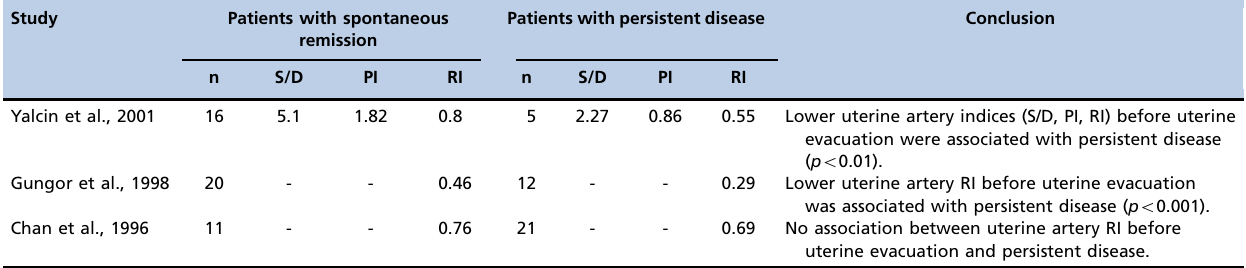
Table 1 - Studies that evaluated the correlation between UA Doppler indices and the development of post-molar trophoblastic tumors before uterine evacuation. n: number of patients; S/D: systolic/diastolic velocity; PI: pulsatility index; RI: resistance